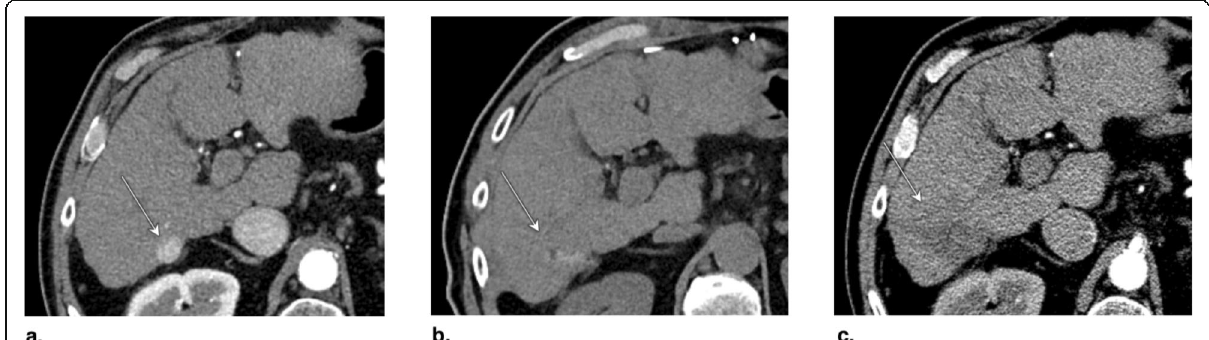
Fig. 11 Axial CT obtained ( a ) pretreatment: image in late arterial phase (AP) shows nonrim arterial phase hyperenhancement of a small peripheral LR-5 observation (arrow). b Immediately post radiofrequency ablation (RFA): unenhanced image shows hyperdense central cavity related to coagulated blood products (arrow). c 3 months post RFA: image in late AP shows unenhanced and enlarged cavity with resorption of blood products. The treated observation is categorized LR-TR Nonviable